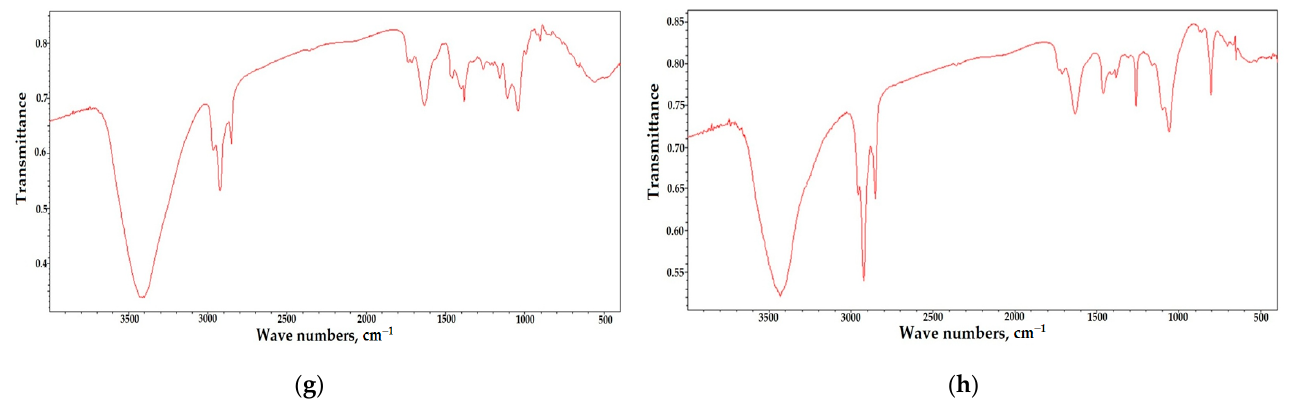
Figure 4. IR spectra of individual BAS. (a) Quercetin; ( b ) luteolin; ( c ) isorhamnetin; ( d ) kaempferol; ( e ) ginkgolide A; ( f ) ginkgolide B; ( g ) ginkgolide C; ( h ) bilobalide; with a degree of purification of at least 95% according to HPLC (wavelength 254 nm).